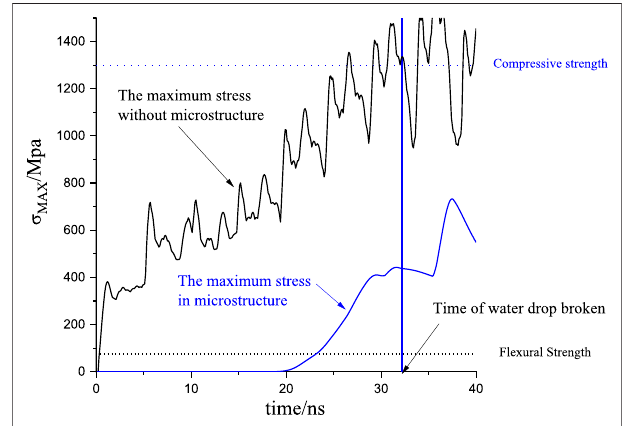
FIGURE 8 | The tendency of the maximum equivalent